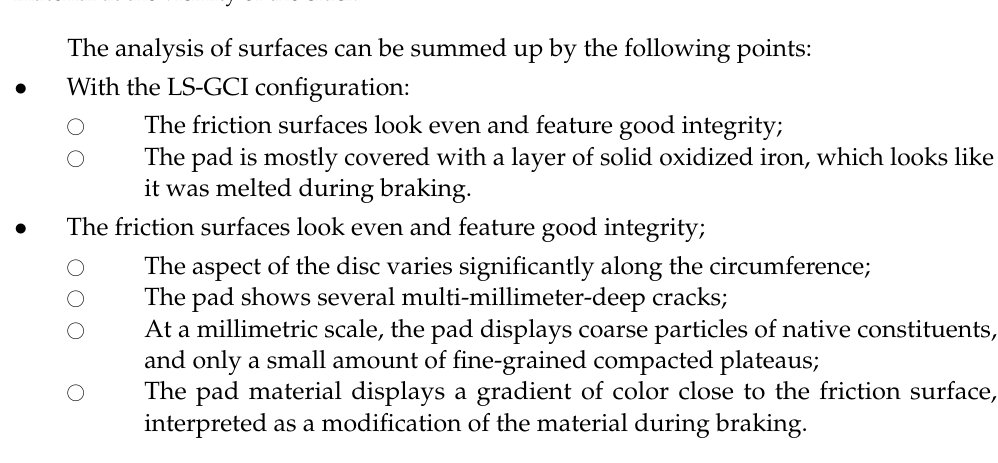
Figure 14. Observation of the face of a crack in a NAO pad: ( a ) Face of the crack; ( b ) aspect of the material at the vicinity of the crack.